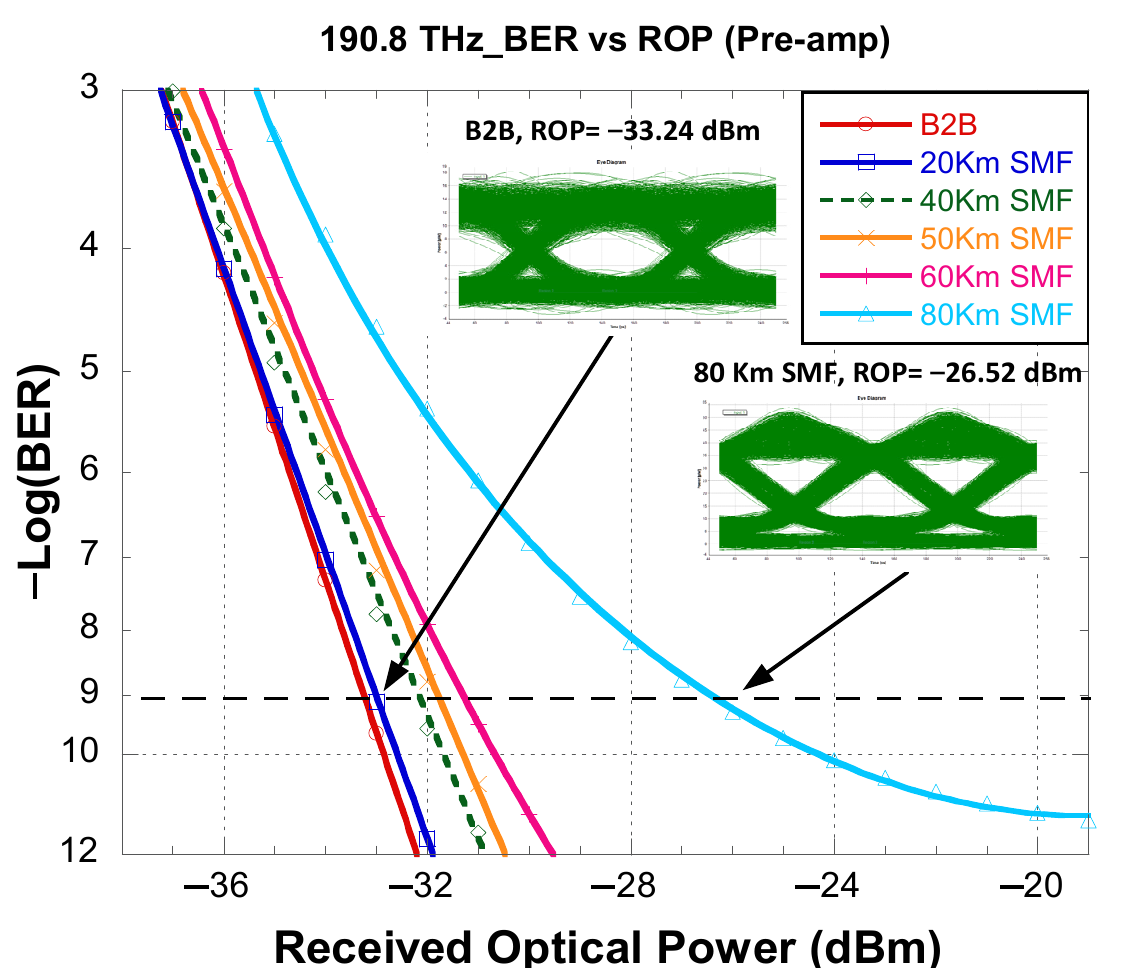
Figure 19. BER curve of CH1 (190.8 THz).